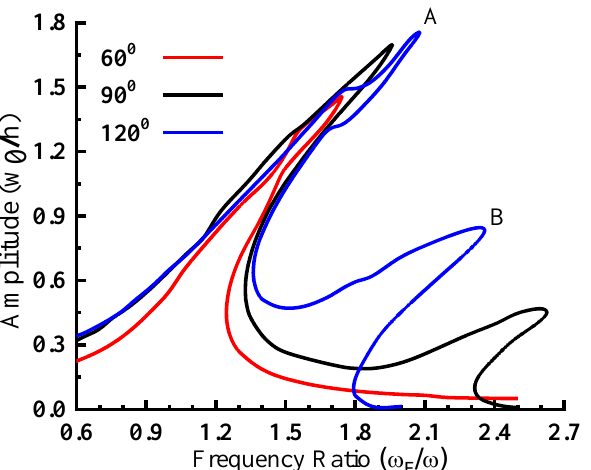
Figure 6. Effect of the sector angle on the nonlinear forced vibration response curves for a laminated annular sector plate ((0 ◦ /90 ◦ ), r 2 / r 1 = 3, b 1 / h = 100, CCCC, f 0 = 30 Pa, b 1 = 1 m, ζ = 0.01).